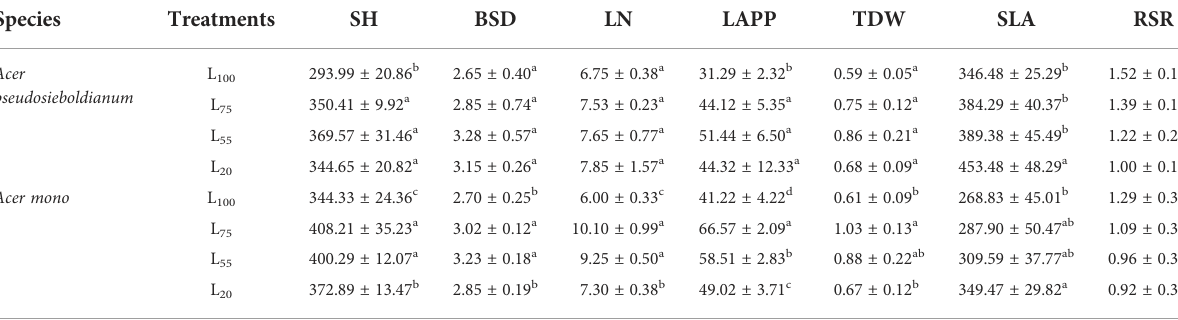
TABLE 2 The growth parameters of two maple seedlings under different light intensity treatments (mean ± SD).